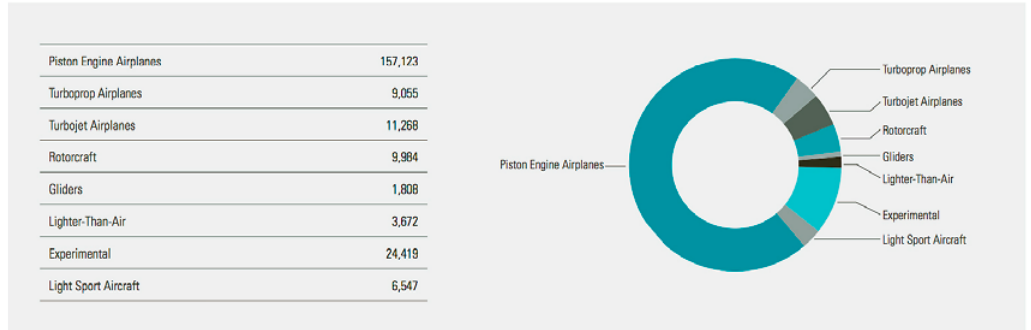
Fig. 2. Number of piston engine airplanes in North American market. From (GAMA 2010)